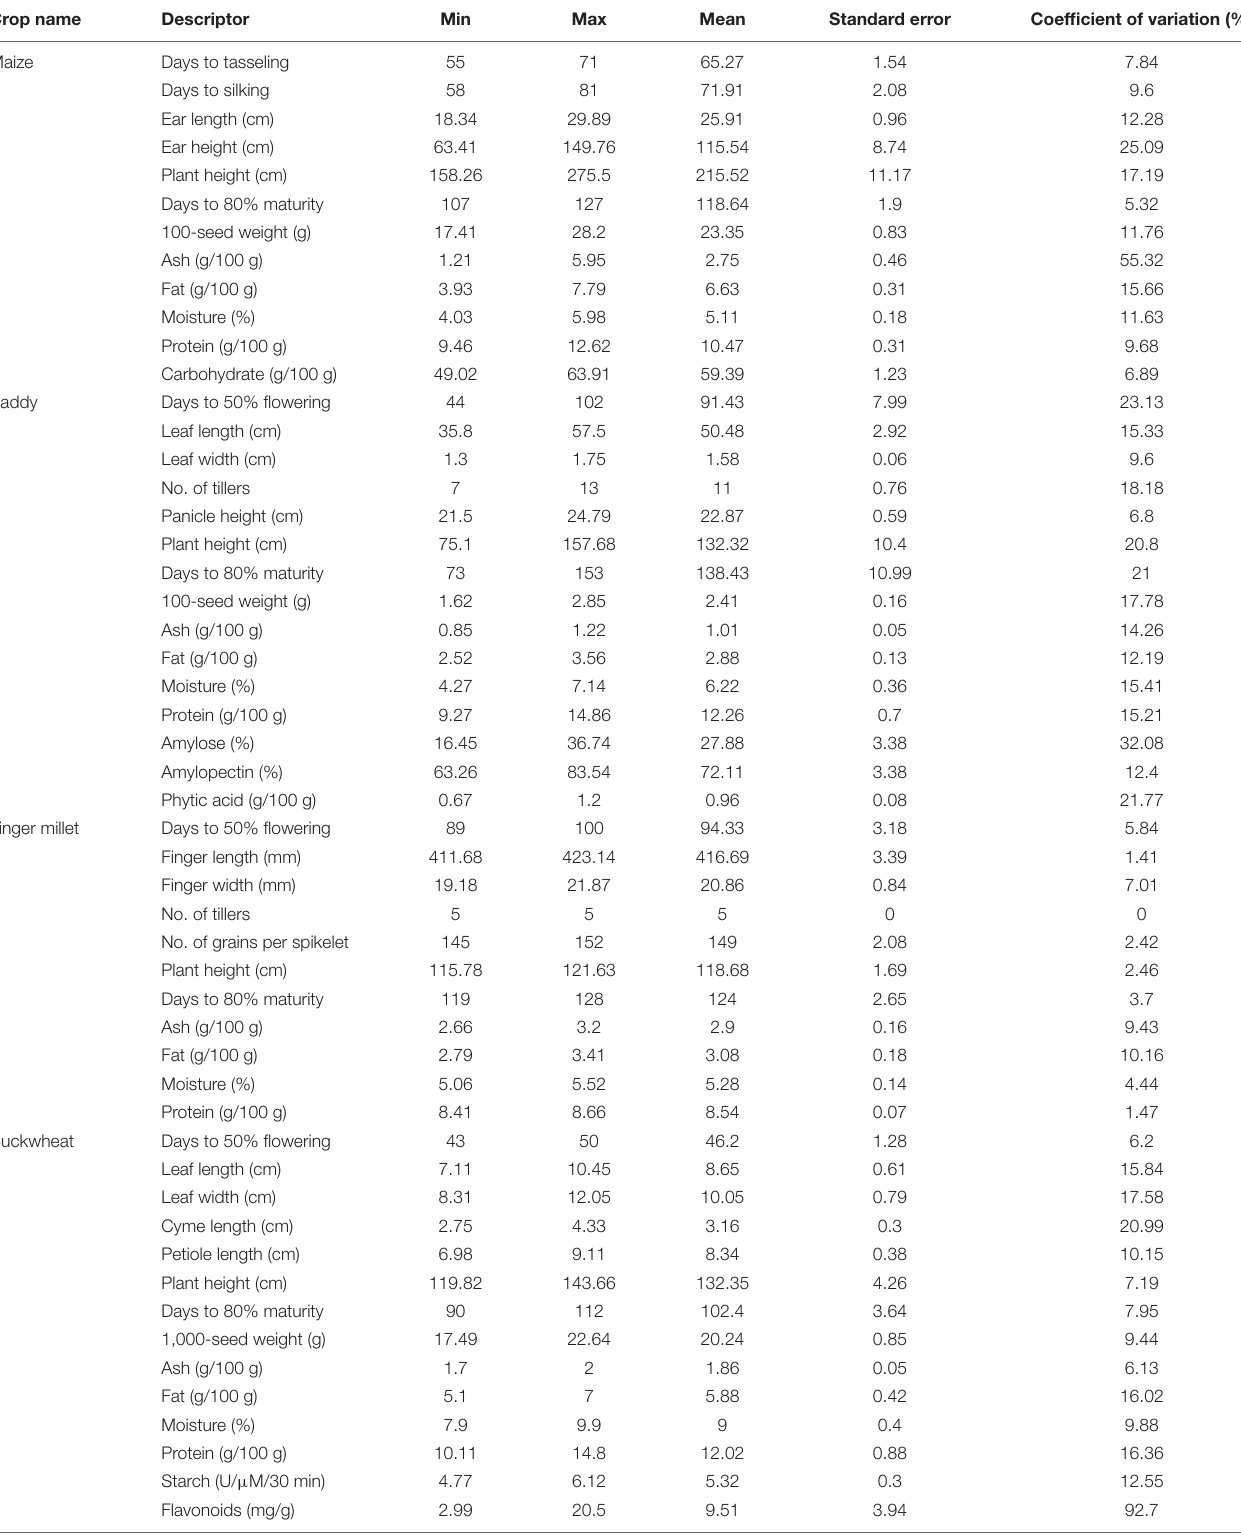
TABLE 2 | Comparative performance of different agro-morphological and nutritional traits of traditional crop